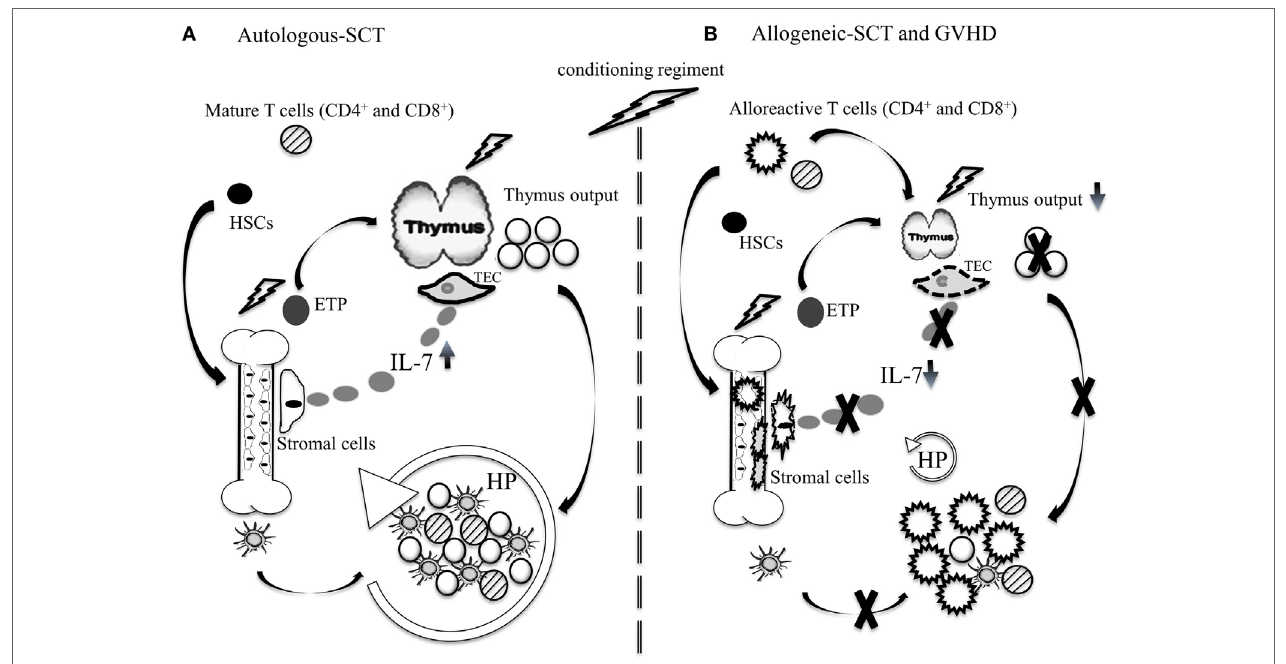
FiGURe 1 | Immune reconstitution after autologous and allogeneic-SCT. (A) Autologous-SCT: chemotherapeutic insults affect the BM and thymopoiesis. During this period, thymopoiesis is inefficient and T cell regeneration occurs primarily through HP of mature T cells contained in the graft. The production of DCs occurs relatively early after autologous SCT and combined with elevated systemic IL-7, produced by stromal cell of primary and secondary lymphoid organs, they induce HP of mature T cells. In younger patients, rapid thymopoiesis recovery contributes to normalize CD4 + T cell counts and T cell receptor diversity. (B) Allogeneic-SCT: the combined GVHD and chemotherapeutic insults to the thymus and the BM induce long-lasting dysfunction of thymopoiesis and the peripheral lymphoid niche. Damages to the BM microenvironment are mediated primarily by alloreactive CD4 + T cells. During GVHD, DC production is reduced and systemic IL-7 is low, which constrain HP of non-alloreactive naïve T cells. Depending on the severity of GVHD and patient’s age, the dysfunction of the thymus can persist for several years.